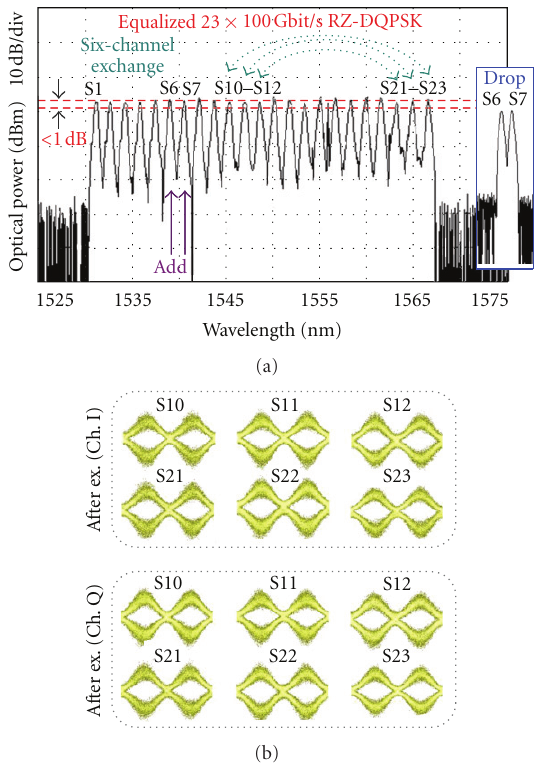
Figure 27: Measured spectrum and balanced eyes after multifunc- tional grooming switch (S6, S7: add/drop; S10, S11, S12, S21, S22, S23: data exchange; S1–S23: power